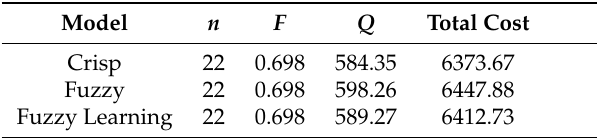
Table 1. Optimal solution of the crisp, fuzzy, and fuzzy-learning models.